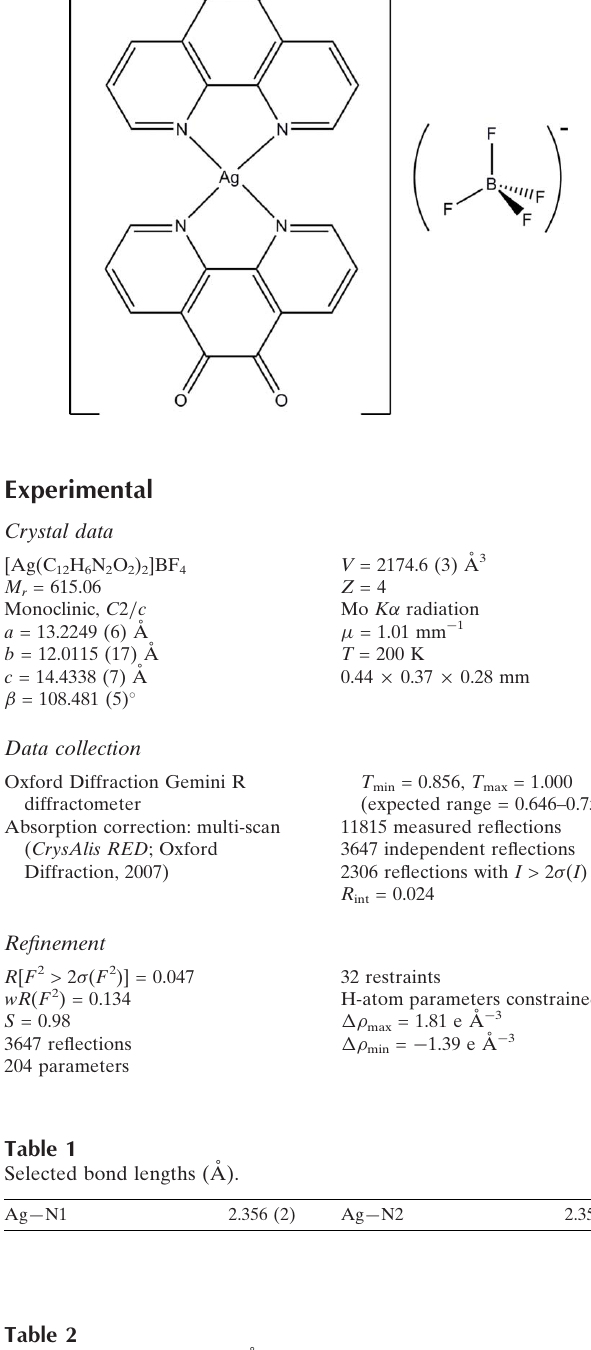
Hydrogen-bond geometry (A˚ , (cid:2)